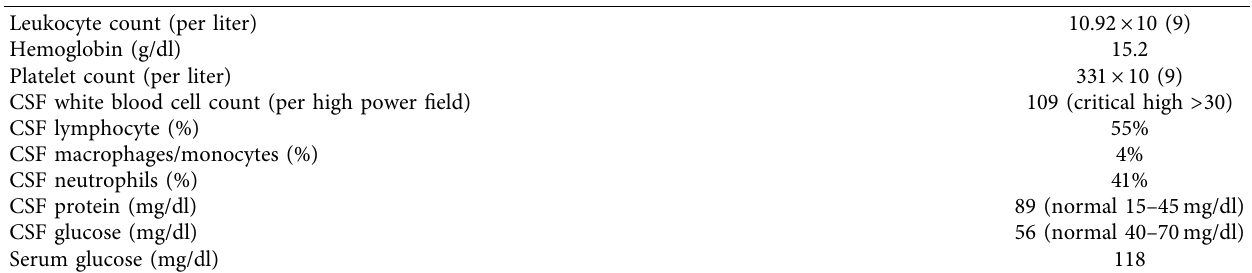
Table 3: Laboratory fndings.